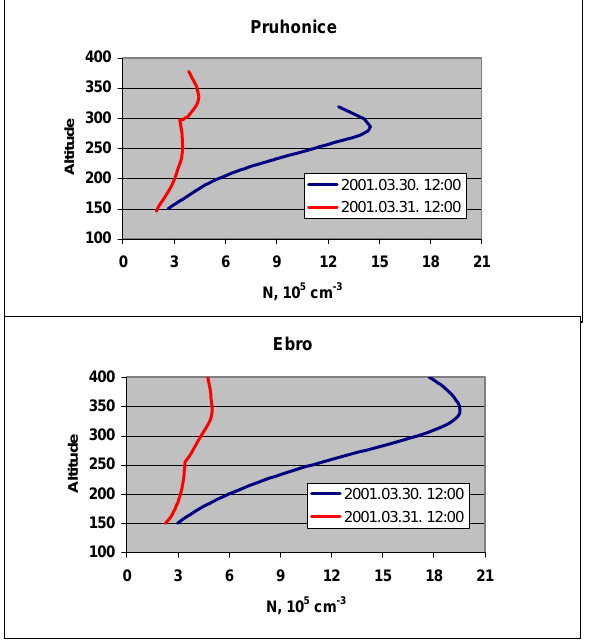
Fig. 9. The noontime electron density profiles in the F-region (150– 350km) for the super storm of March/April 2001, one day before the storm onset (blue line) and during the storm main phase (red line) for Pruhonice and Ebro. Altitude in km, electron density N in 10 5 cm − 3 .